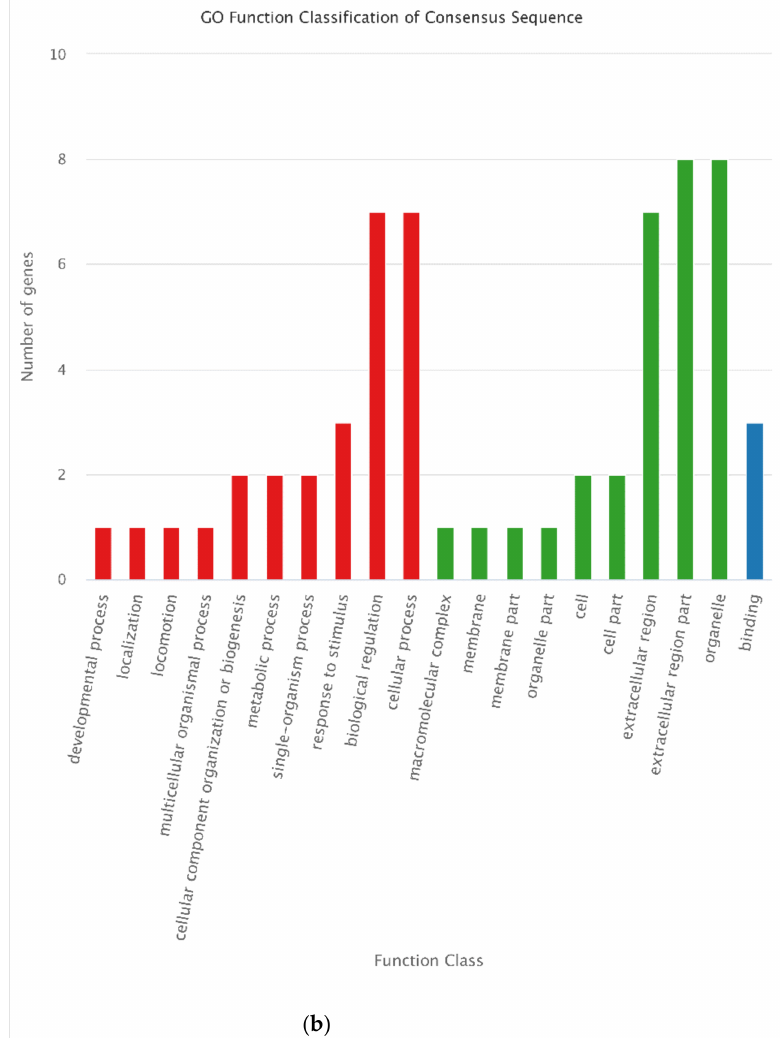
Figure 14. GO classification of DEGs and DEPs with the reverse trend. For GO an-notation, the abscissa is the GO term, and the ordinate indicates the number of DEGs annotated to GO terms. ( a ) GO classification of DEGs with the reverse trend to DEPs. ( b ) GO classification of DEPs with the reverse trend to